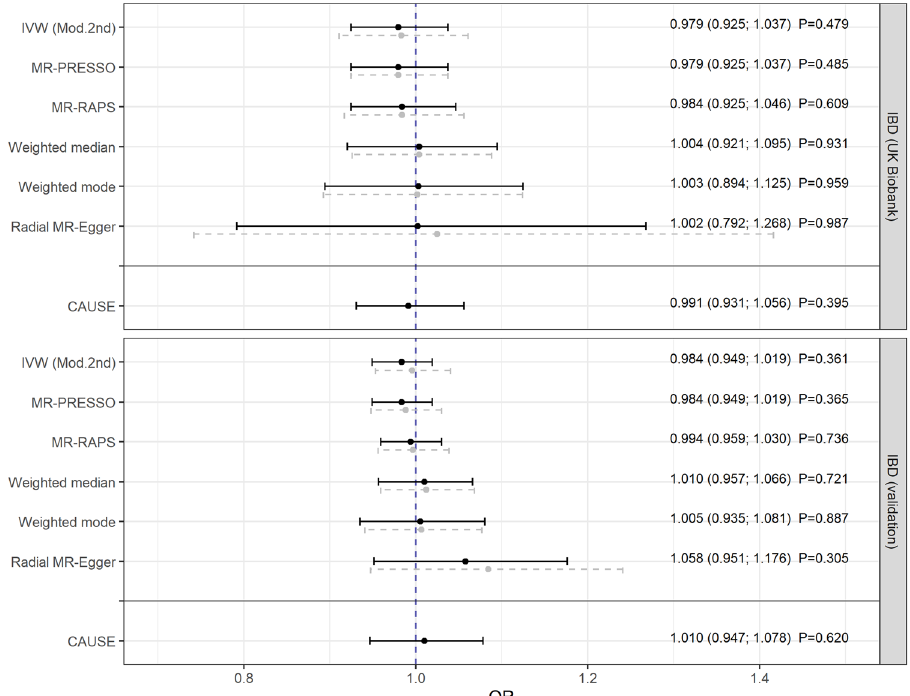
Fig. 1 Mendelian randomization estimates given as odds ratios (ORs) and 95% con fi dence intervals for the causal effect of genetically predicted in fl ammatory bowel disease (IBD) on Parkinson ’ s disease (PD). The ORs can be interpreted as the average change in the outcome per 2.72-fold increase in the prevalence of the exposure. Analyses based on two different genome-wide association studies. Dashed gray lines represent the results before and black lines the results after outlier removal.